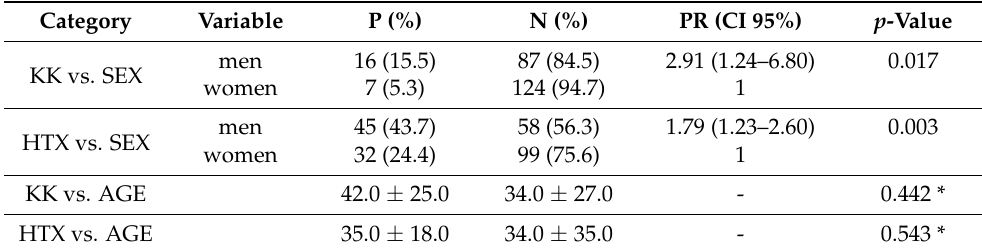
Table 1. Distribution of positive results by Kato-Katz and Helmintex according to sex and age.